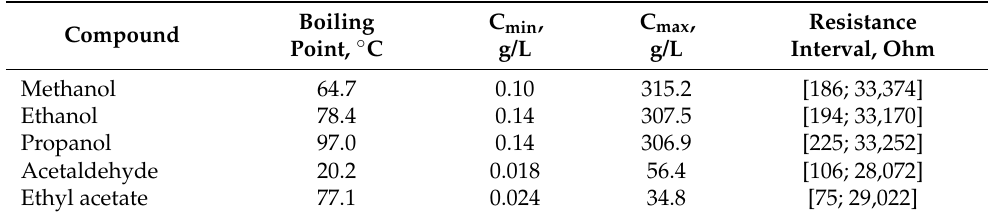
Table 3. Concentration ranges in the individual standard calibration and overall sensor resistance signal